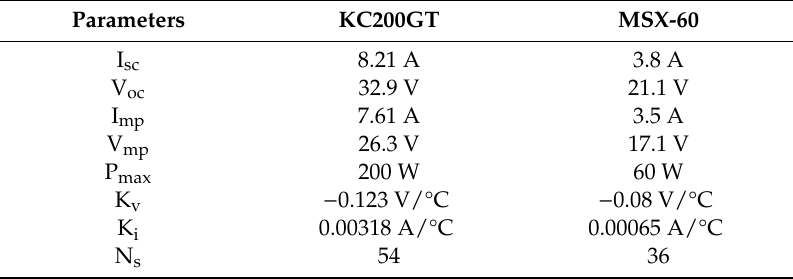
Table 1. Specification of PV Modules.